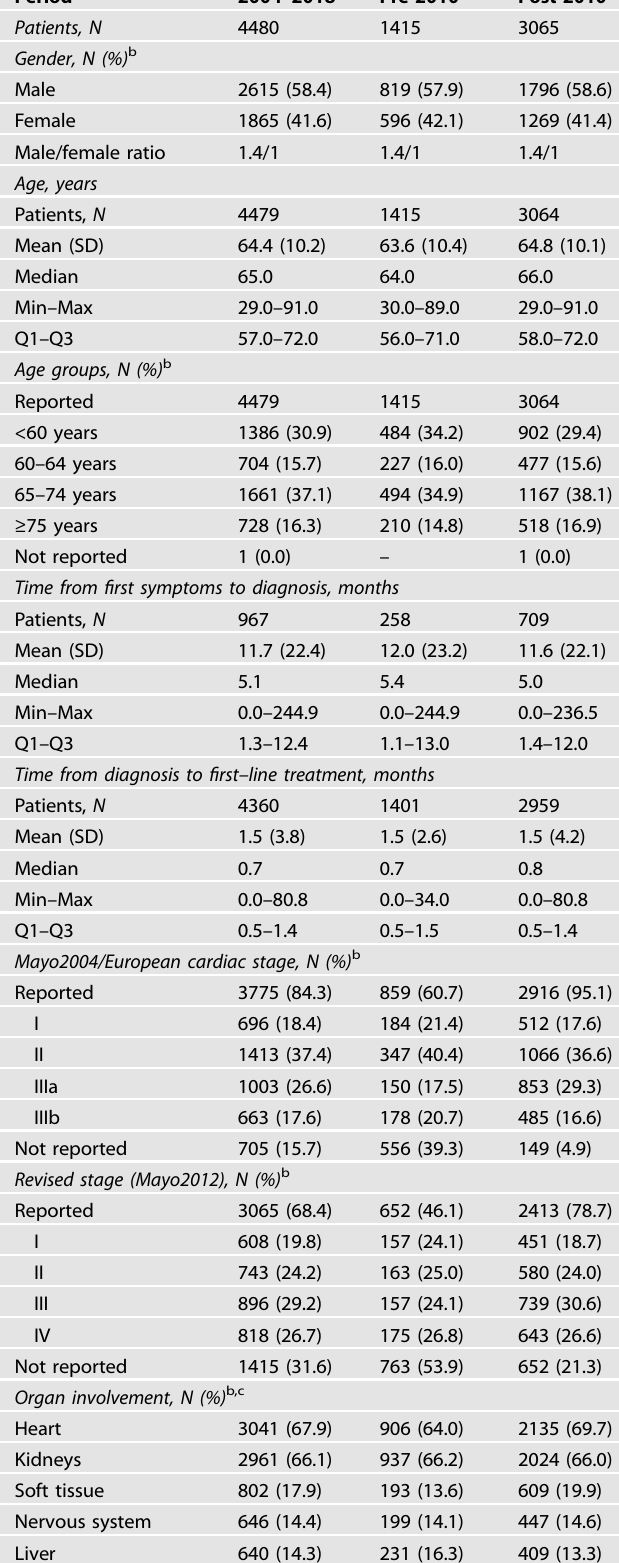
Table 1. Patient demographic and disease characteristics at diagnosis, overall (2004 – 2018), and by fi rst-line treatment initiation period (pre- and